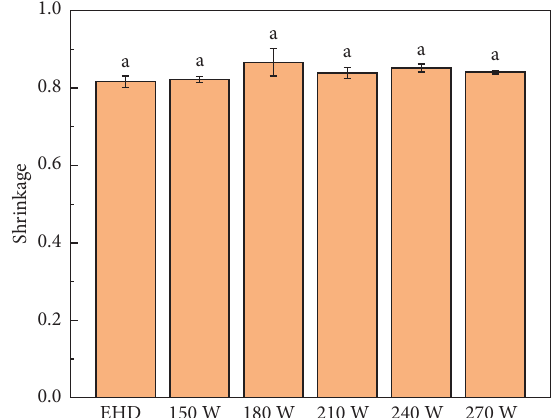
Figure 7: Diagram of the shrinkage rate change in potato slices under different ultrasonic pretreatment conditions. Data are shown as the mean ± SD. For each response, means with different low- ercase letters are significantly different ( p < 0 .